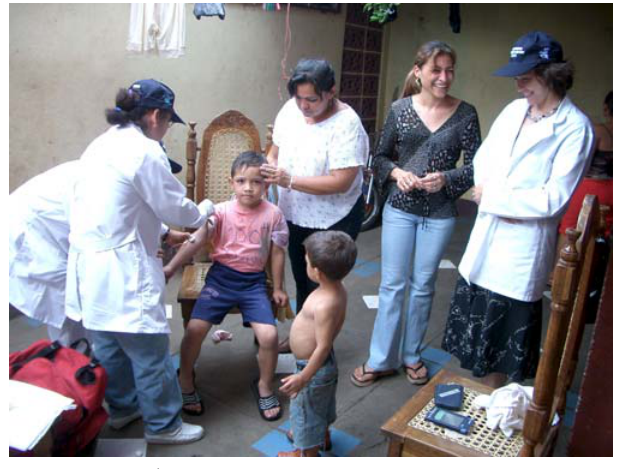
Figure 1. Annual Collection of Serological Samples, Managua, Nicaragua,